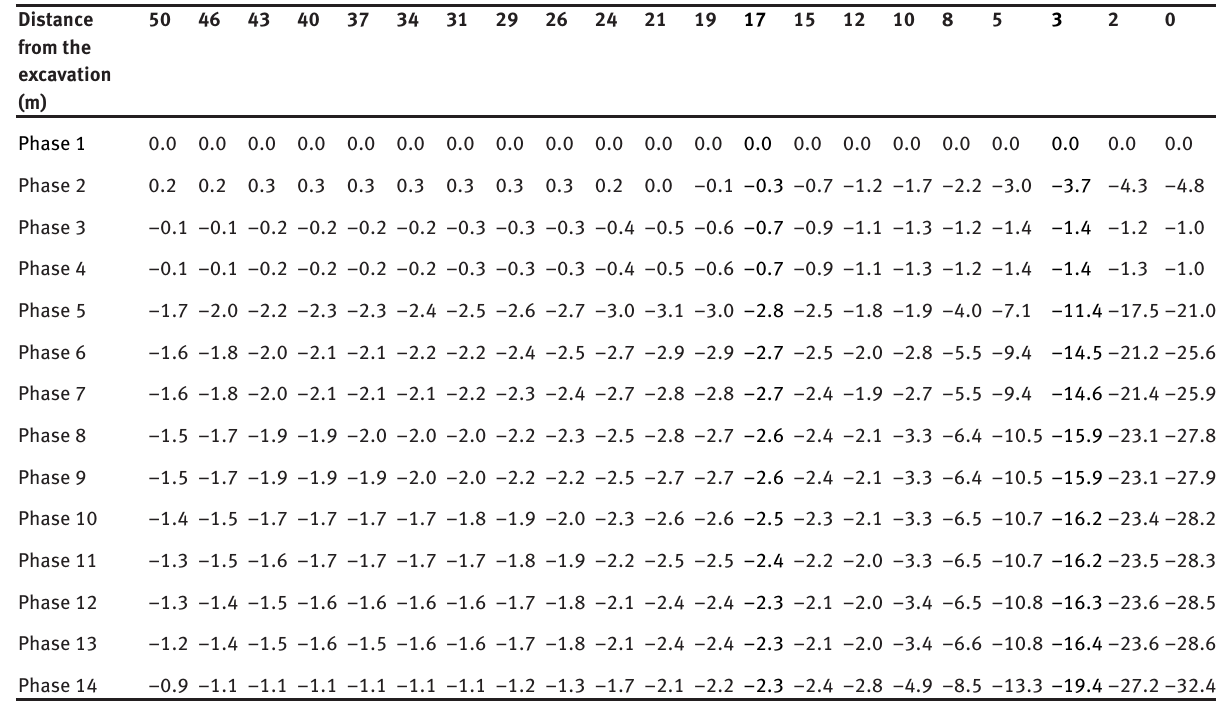
Table 2: The juxtaposition of the vertical displacement values in [mm] of the land surface. from the 3D numerical model in the analyzed implementation phases. for the left side of the A–A test cross–section.